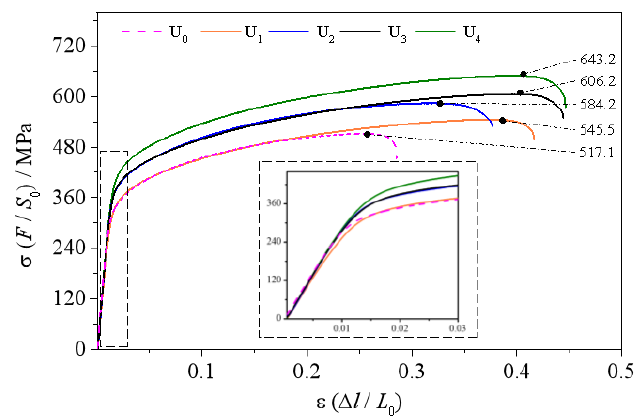
Figure 11 . Tensile comparison curves of different samples. Table 4. Comparison of tensile parameters of